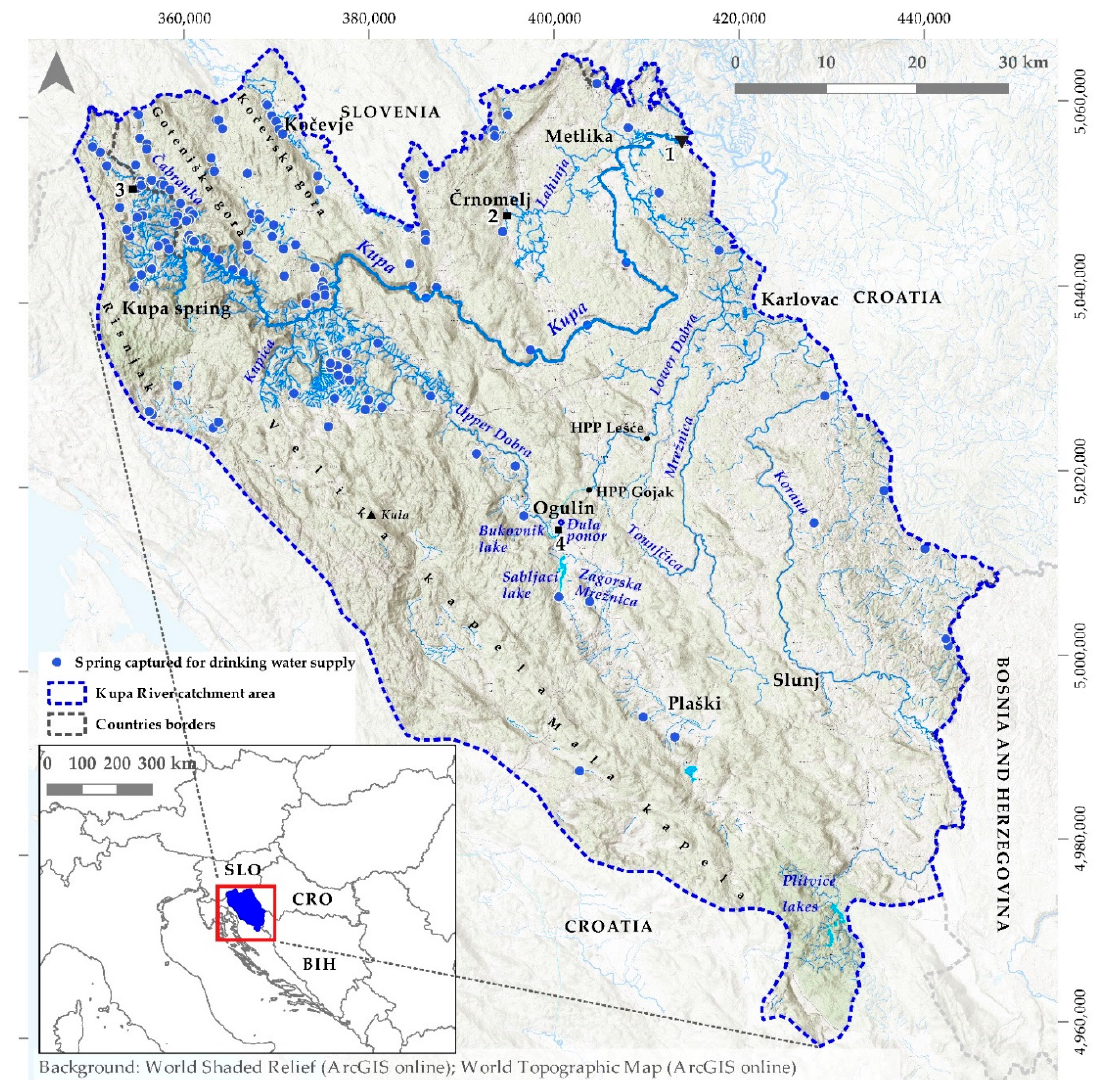
Figure 1. Location of the study area ((1) hydrological station Kamanje; meteorological stations: (2) Č rnomelj, (3) Parg, (4) Ogulin).